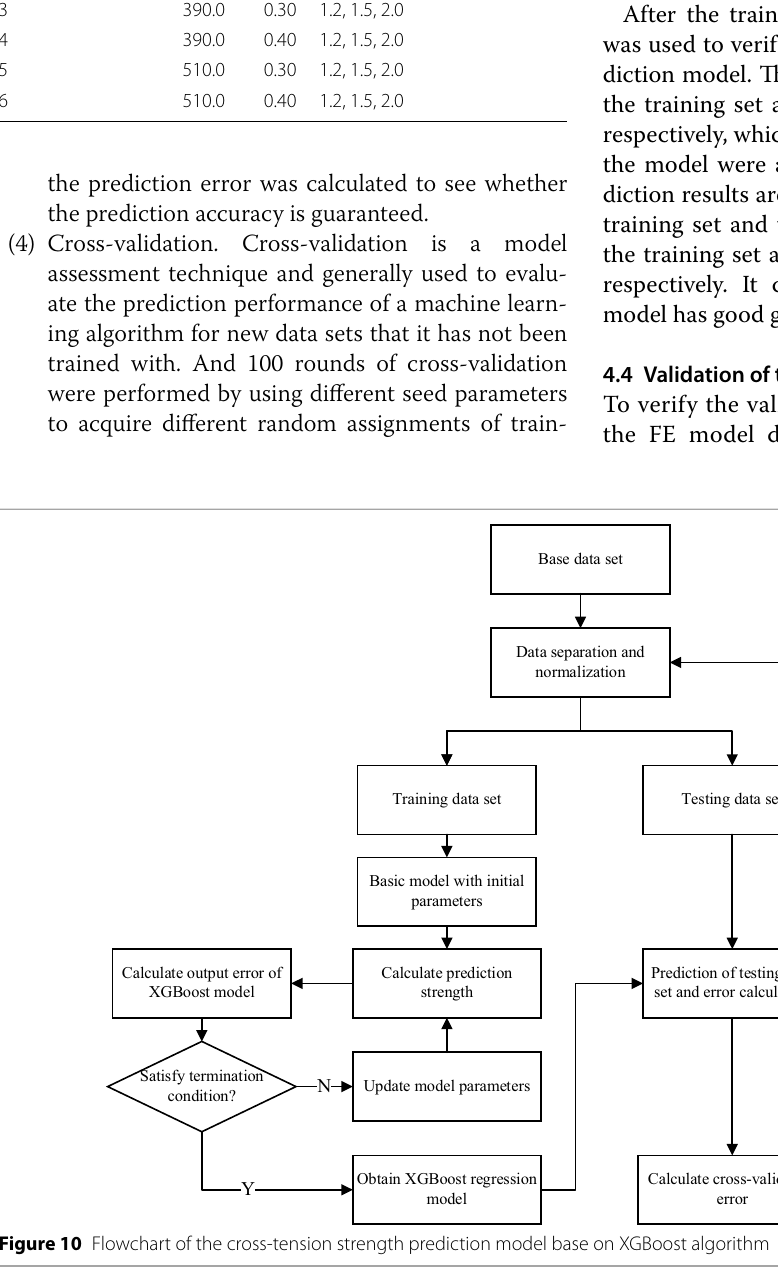
Figure 10 Flowchart of the cross-tension strength prediction model base on XGBoost